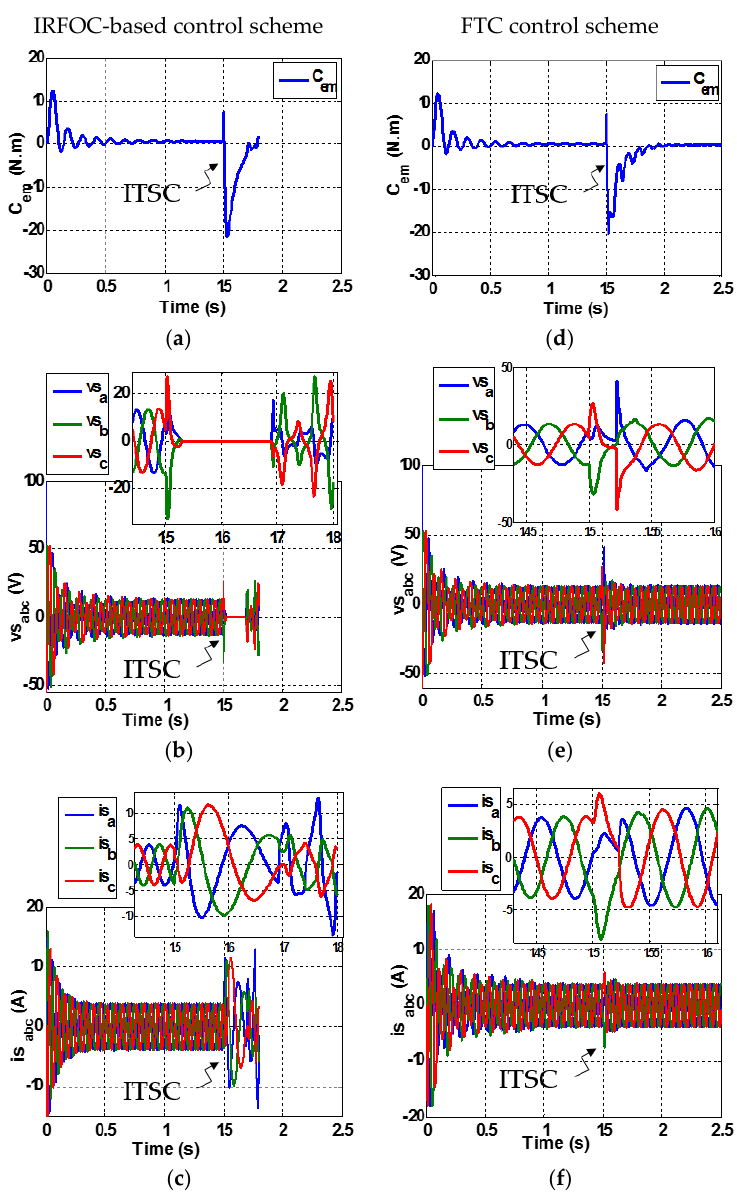
Figure 9. Simulation comparison between the components of the IRFOC-based control scheme (left side) and FTC-based control scheme (right side): ( a , d ) the electromagnetic torque C em ; ( b , e ) three-phase IG stator voltages v sabc ; and ( c , f ) three-phase IG stator currents i sabc with their zooms at t = 1.5 s of wind turbine system IG with ITSC fault of 80% of s 1 -phase.